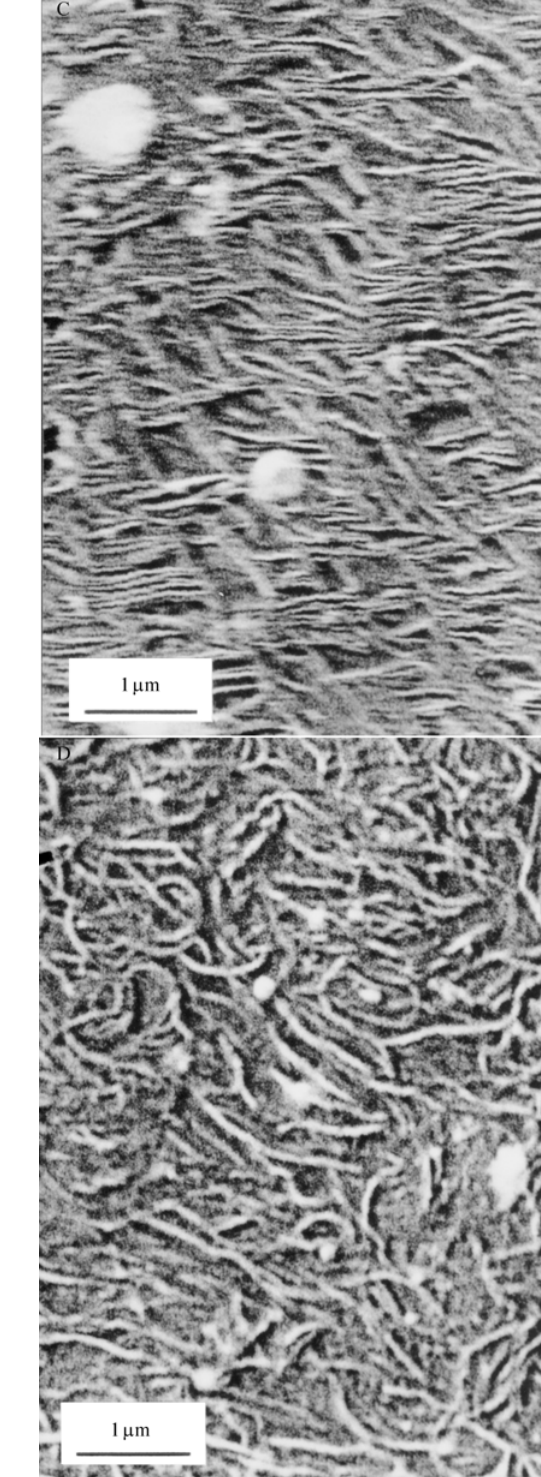
Figure 5. Detection of transcrystallization in the low voltage scanning electron microscope (LVSEM). Approximate sample locations for SEM observation marked T (transcrystallinity) and S (spherulitic crystallization) on optical micrograph in (a), region T immediately above UHMWPE fiber observed at low magnification by LVSEM in (b), central region T with lamellar resolution above fiber in (c), spherulitic matrix region S with lamellar resolution away from fiber in (d). Original magnification 100X in (a), 3.000X in (b), 15.000X in (c) and